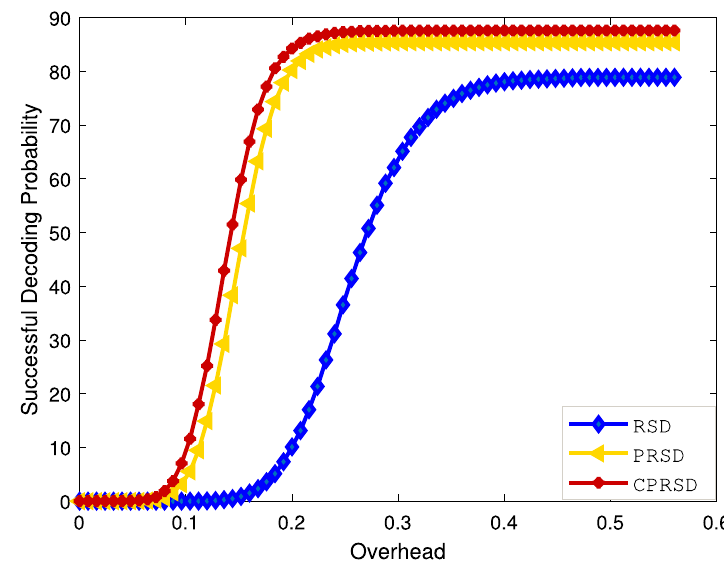
Fig. 11 Successful decoding probability for k = 250 in removal